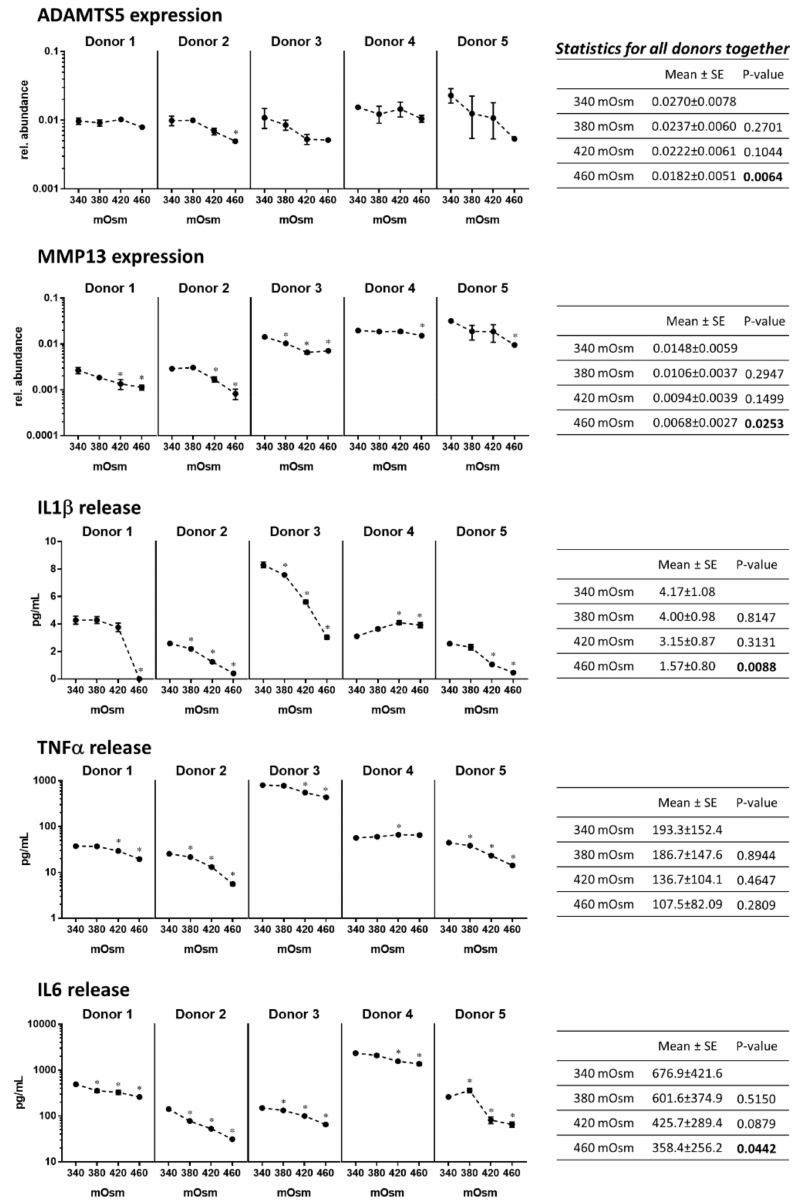
Figure 2. Human OA chondrocytes from five donors were cultured for six days in a monolayer at 340, 380, 420 and 480 mOsm. The gene expression of ADAMTS5 and MMP13 was evaluated by RT-qPCR and the release of IL1 β , IL6 and TNF α was evaluated with a cytokine multiplex assay (see Materials and Methods). Data on the graphs represent the mean -standard error of the mean of technical replicates ( n = 3–6). Statistical analysis was performed for each donor separately (* means significantly different from 340 mOsm with p < 0.05) and for all donors together with the means, standard errors of the mean (SE) and p values for the comparison to 340 mOsm being tabulated on the right ( p values in bold when p ≤